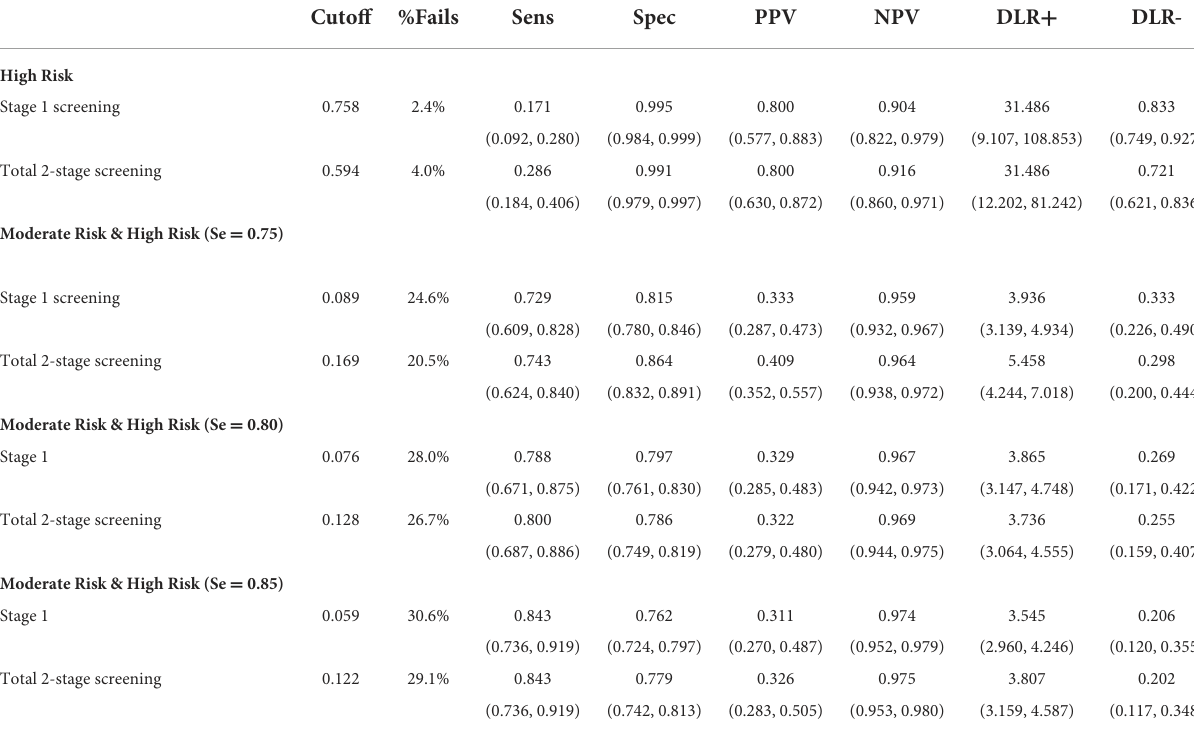
TABLE 4 Diagnostic accuracy statistics for different cutoffs (95%